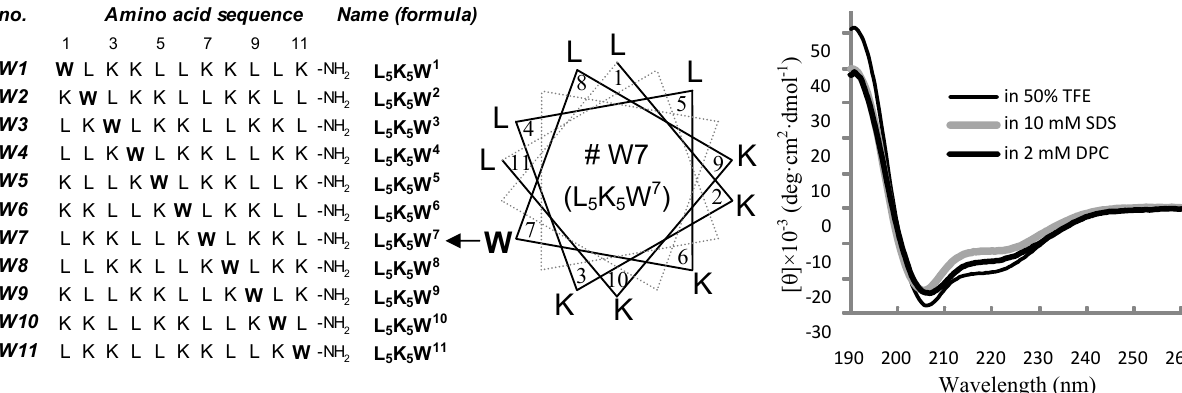
Figure 1. Peptide design and conformational validation. Amino acid sequence of each K W n model peptide (left panel) is labeled with the serial number on the left and the L 5 5 peptide name as a formula on the right. An example of the helical wheel diagram (middle panel) is depicted for the W7 peptide. Far-UV CD spectra (right panel) of the W7 peptide were measured in 10 mM phosphate buffer (pH 6.5) containing 50% TFE, 10 mM SDS micelles and 2 mM DPC micelles,